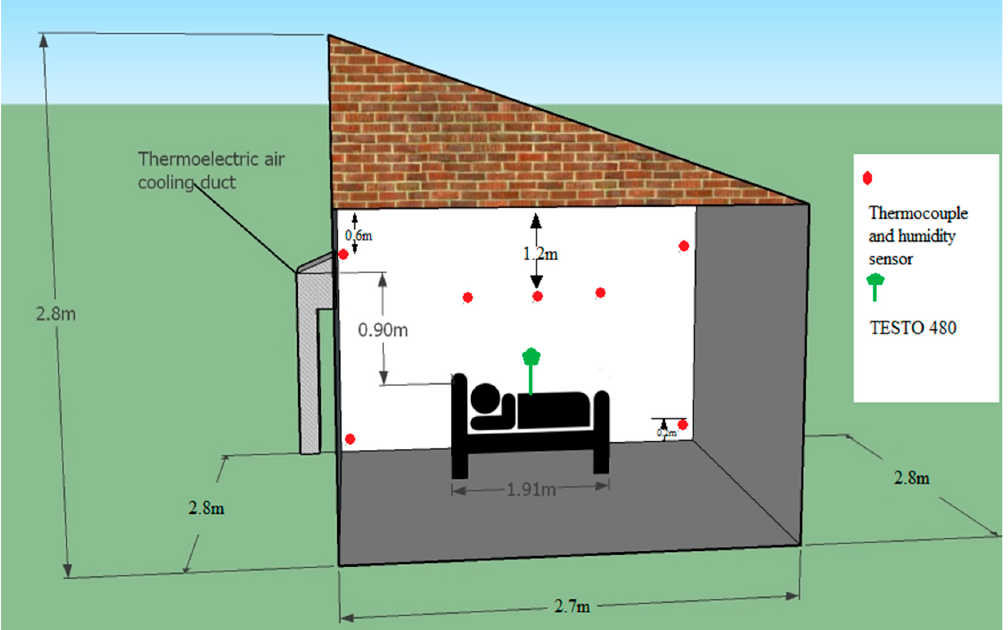
Figure 2. Schematic diagram of the test room used for sleeping analysis.